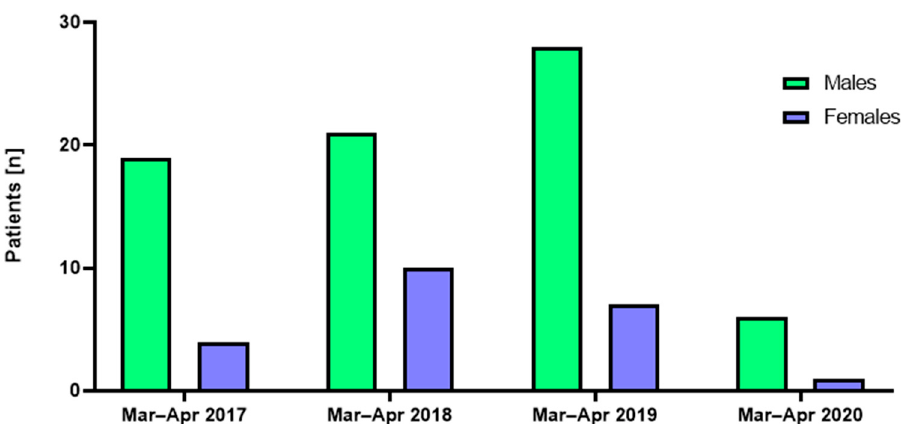
Figure 3. Trauma patients (males and females) admitted during March and April to the GMC trauma center in the years 2017–2020.